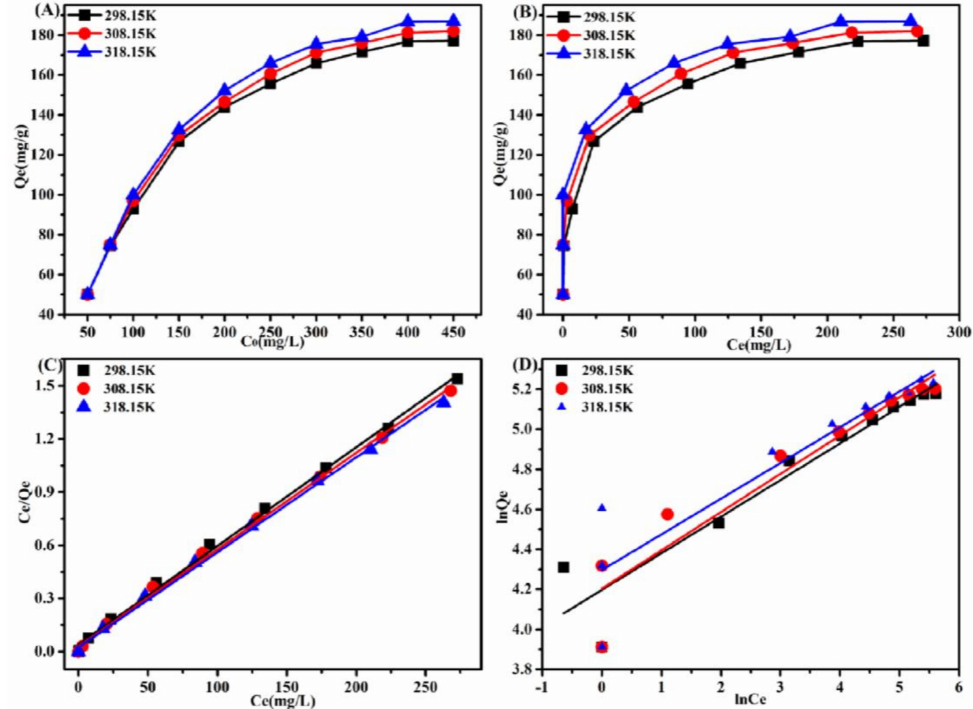
Figure 9. ( A ) Adsorption capacity versus initial Ce(III) concentration; ( B ) The isotherm curves of Ce(III) for the magnetic PMMA-PGMA-PEI; ( C ) Linearized Langmuir ( D ) and Freundlich isotherm model at various temperatures (Adsorbed dose = 80 kGy, dose rate = 20 kGy/pass, dose = 1.0 g/L, GMA concentration = 40 wt%, contact time = 24 h, pH = 6, C 0 = 50, 75, 100, 150, 200, 250, 300, 350, 400, 450 mg/L, T = 298.15, 308.15, 318.15